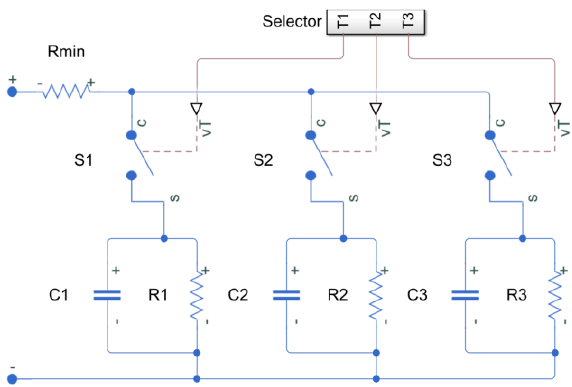
Fig.4: Equivalent electric circuit of a biological